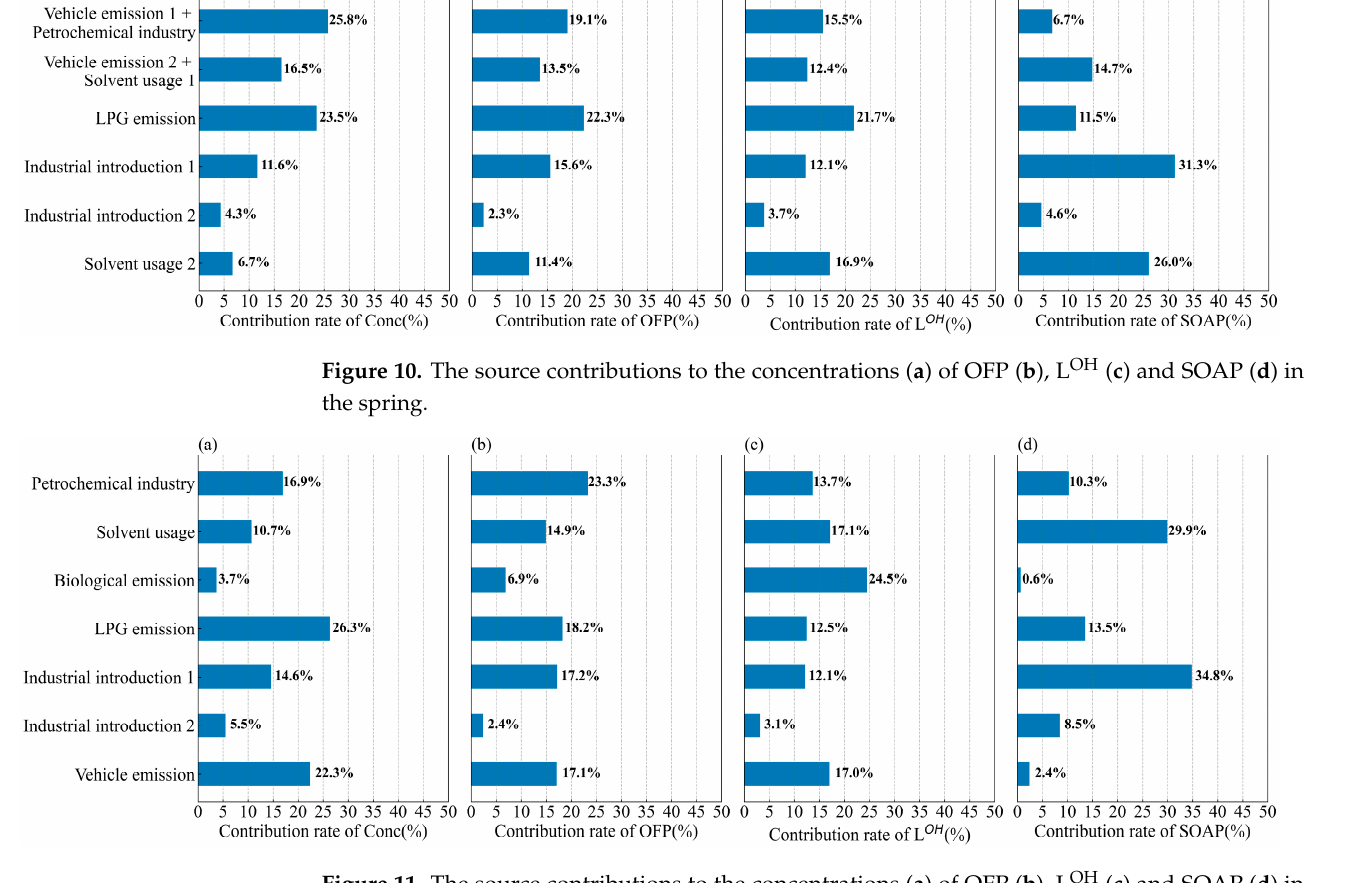
Figure 11. The source contributions to the concentrations ( a ) of OFP ( b ), L OH ( c ) and SOAP ( d ) in the summer.